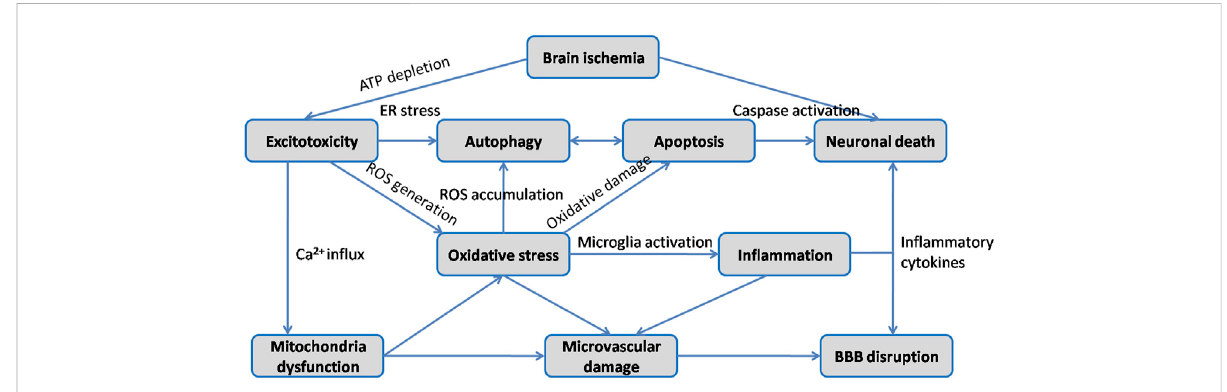
FIGURE 3 Schematic diagram of the main pathophysiological mechanisms in cerebral I/R